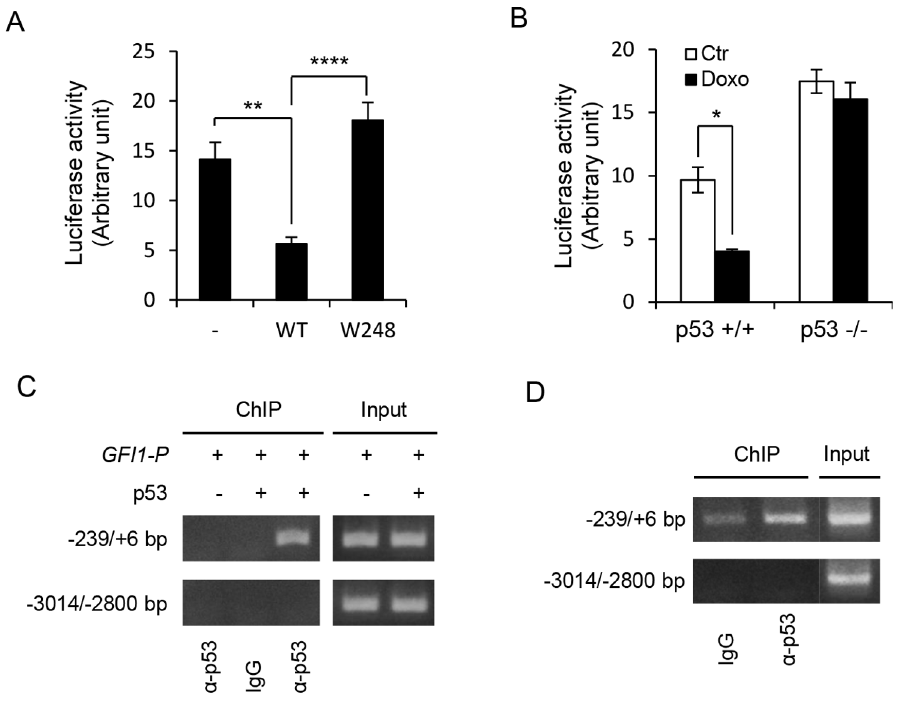
Figure 3. p53 binds to and represses GFI1 . (A) p53 2 / 2 HCT116 cells were transfected with the GFI1 promoter ( 2 1933/ + 468 bp) luciferase reporter construct along with the wild type (WT) or W248 mutant p53. Luciferase activities were measured 36 hrs later and normalized for b -Gal activities. Data are shown as mean 6 SD. (B) p53 + / + and p53 2 / 2 HCT116 cells were transfected with GFI1 promoter luciferase reporter construct and treated with Doxo (400 ng/ml) 8 hrs later. Luciferase activities were measured 16 hrs after Doxo treatment. (C) p53 2 / 2 HCT116 cells were transfected with pGL3-basic plasmid containing GFI1 promoter fragment ( 2 4840/ + 184 bp) either alone or together with p53. ChIP assays were carried out using the anti human p53 or an irrelevant species-matched antibody. The indicated regions of GFI1 promoter were amplified by PCR. (D) ChIP experiment was carried out on Molt3 cells using the anti human p53 and control antibodies.